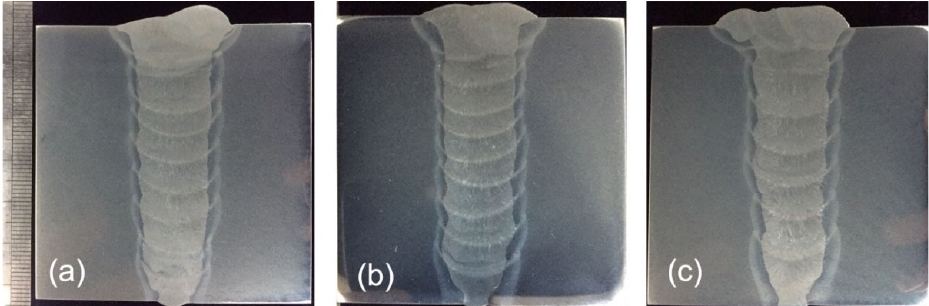
Figure 3. Cross ‐ sections of the narrow ‐ gap GMA welded joints under different welding speeds: ( a ) 350 mm/min; ( b ) 300 mm/min; ( c ) 250 mm/min. ( a ) 350 mm/min; ( b ) 300 mm/min; ( c ) 250